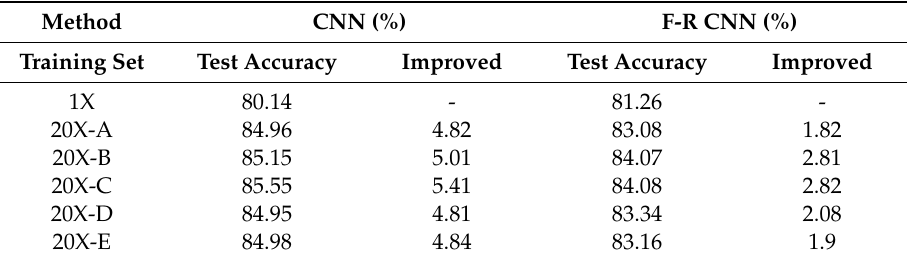
Table 11. Test accuracy of different training sample sets.